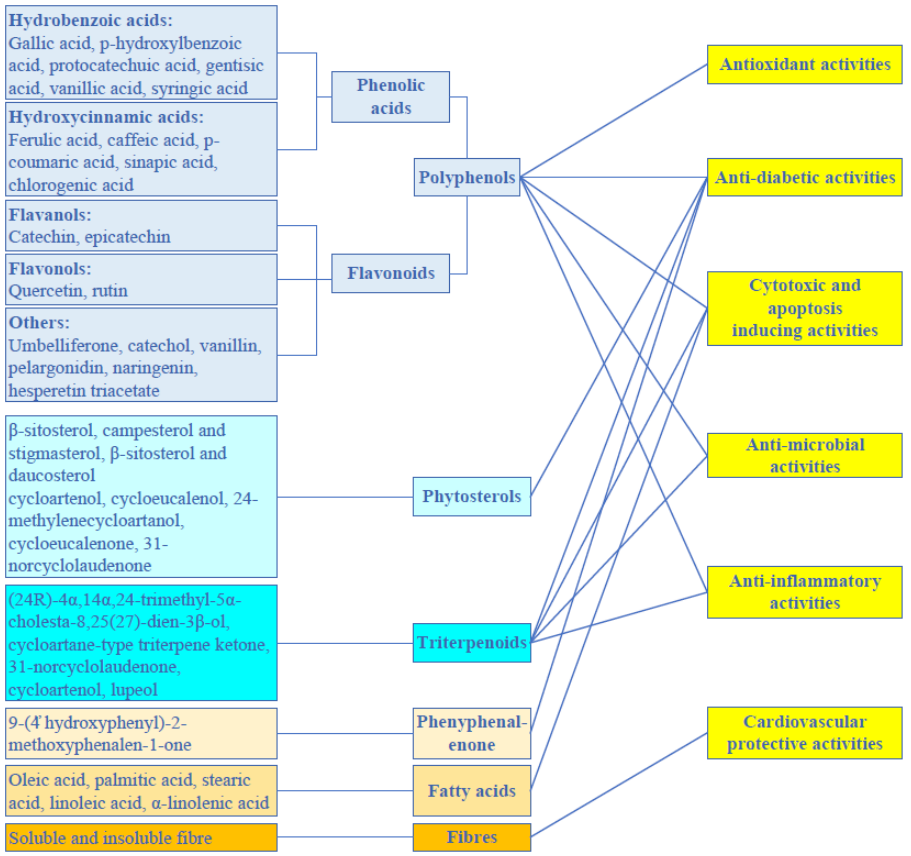
Figure 4. Relationship between the banana inflorescence’s phytochemical components and its prac- tical characteristics. Adapted from